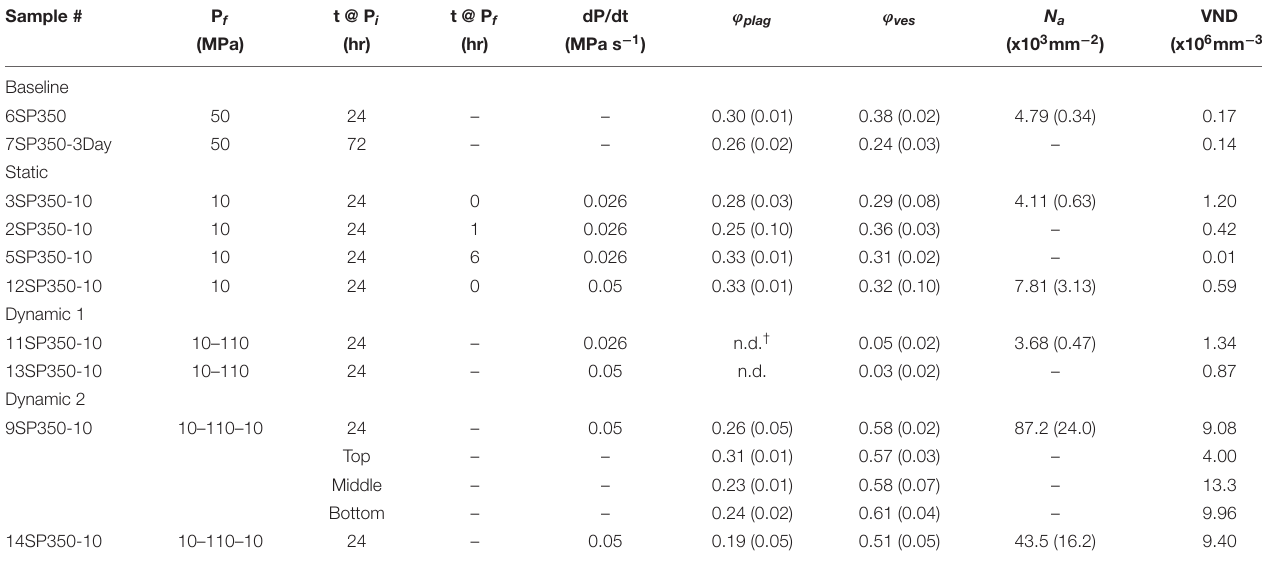
TABLE 1 | Experimental run conditions and